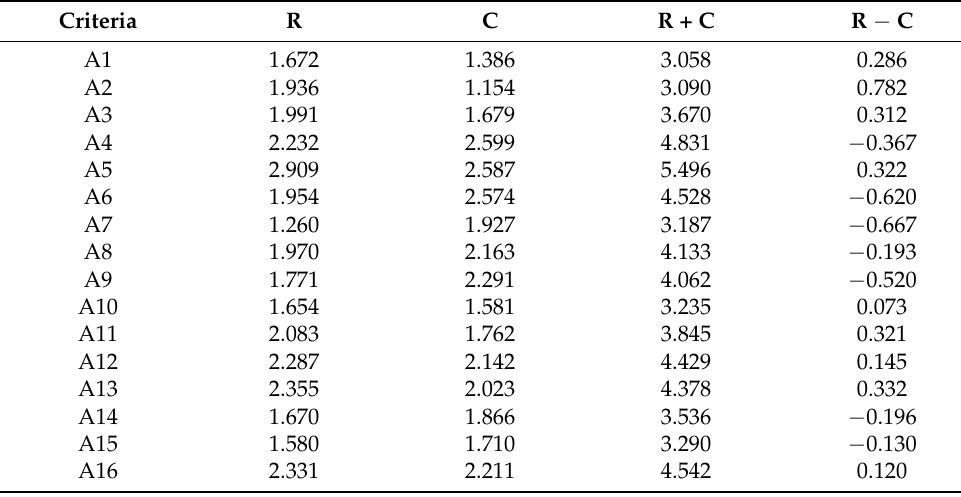
Table 7. The values of R, C, (R + C), (R − C)—the TBL’s